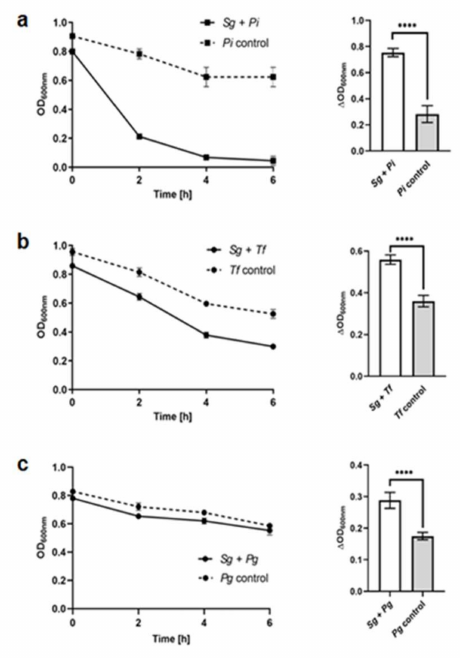
Figure8. Interactionof S.gordonii withperiodontopathogens. Thetendencyof S.gordonii toco-aggregate with ( a ) P. intermedia , ( b ) T. forsythia , and ( c ) P. gingivalis was monitored by measuring optical density at 600 nm at the indicated time points (left panel) or after 6 h (right panel). Pi , Prevotella intermedia ; Tf ,